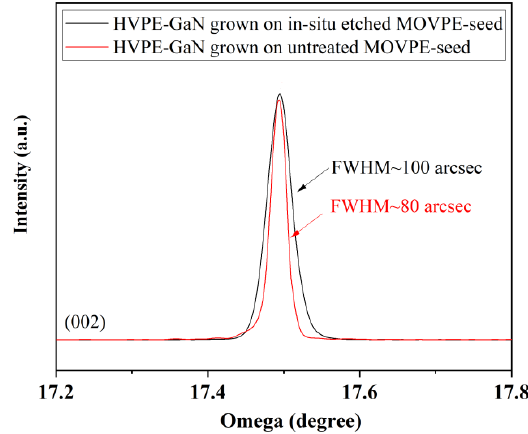
Figure 9. XRD rocking curves of HVPE GaN crystals grown on in-situ etched and untreated MOVPE GaN seed in reflection (002) ω-scan mode.